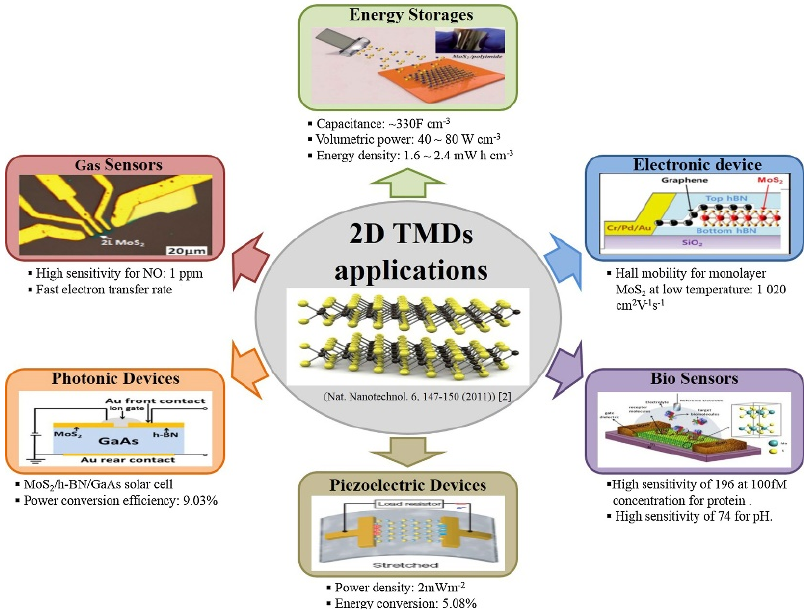
Figure 5. Typical applications of 2D TMDs. Reprinted with permission [2–7]. Ref. [2]